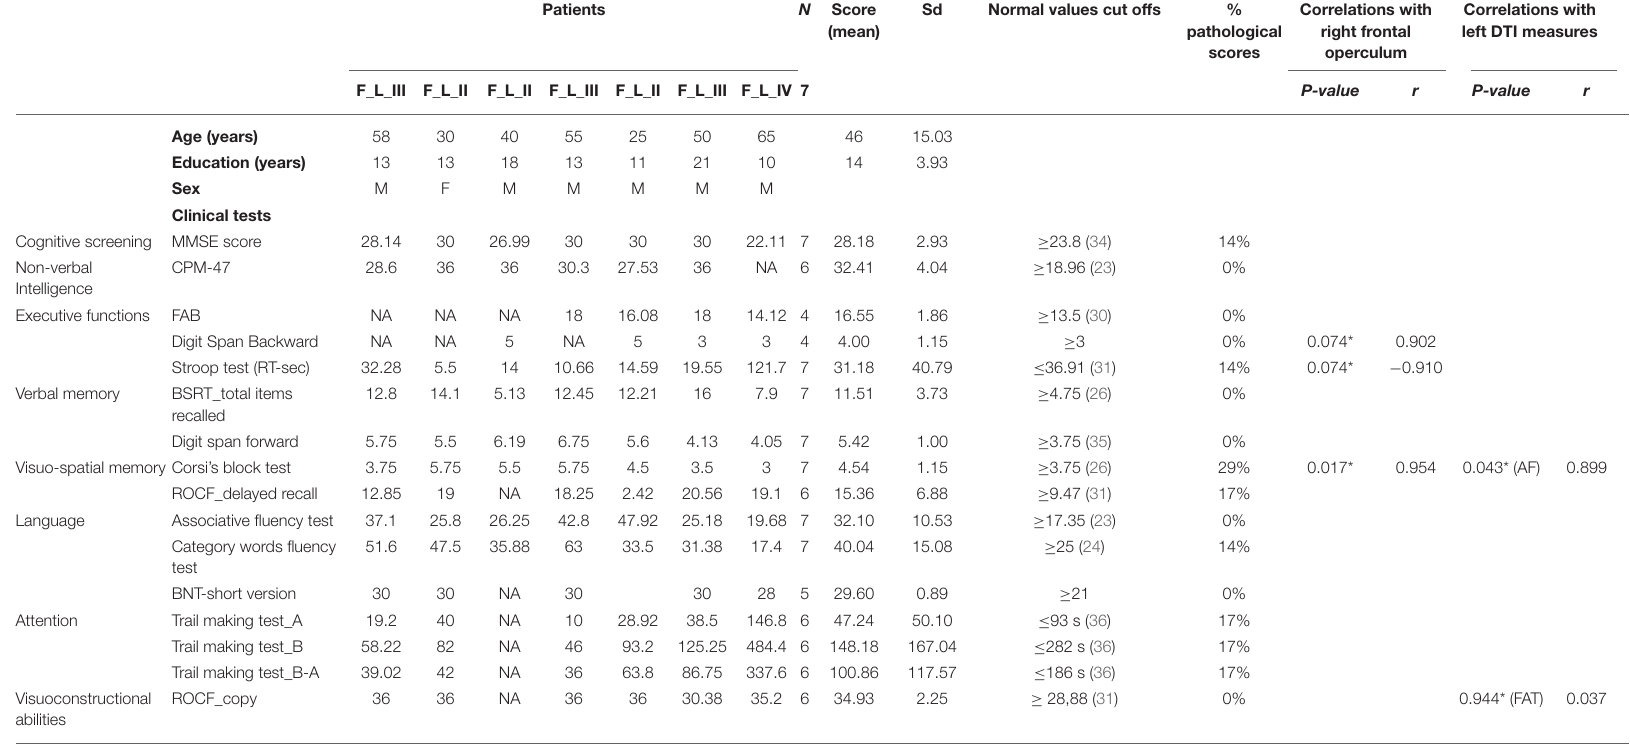
Patients N Score